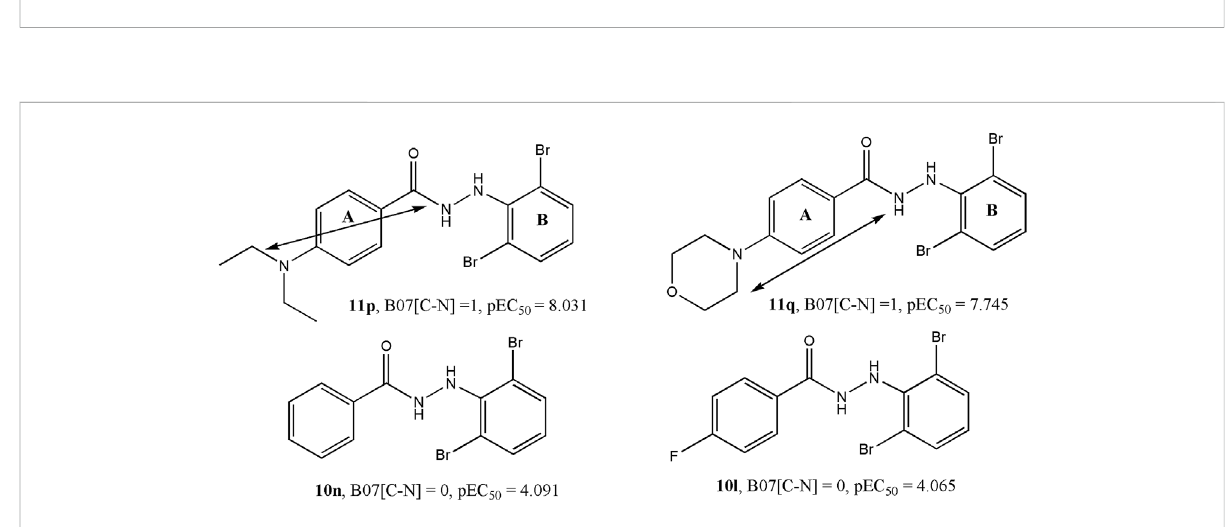
FIGURE 4 Importance of the B07[C-N] descriptor with respect to the dataset